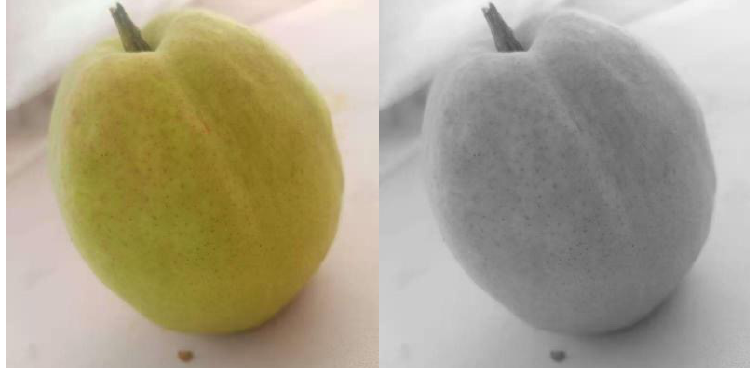
Figure 2. Image comparison before and after image grayscale